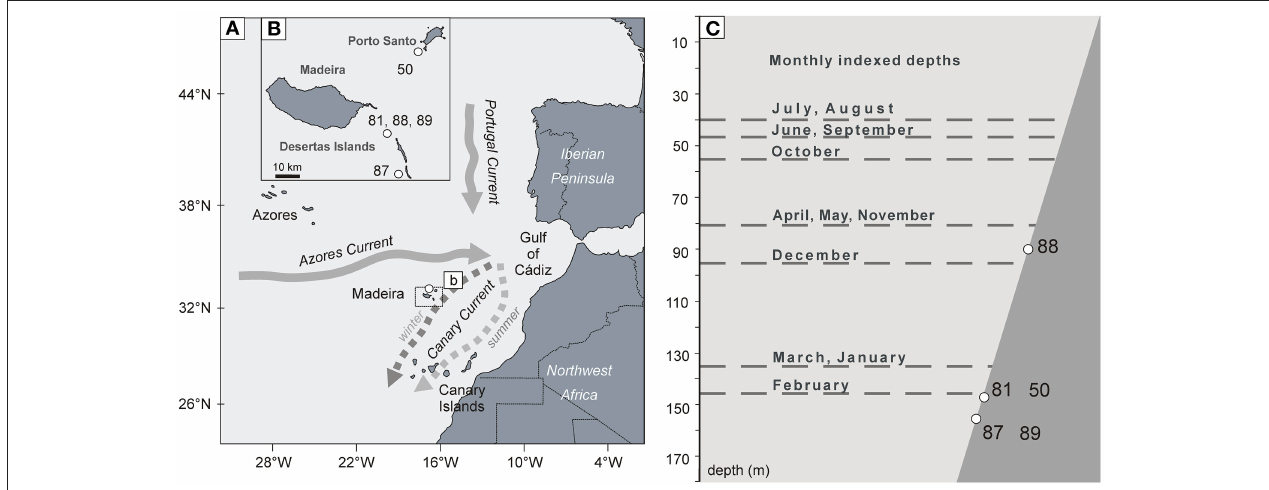
FIGURE 1 | (A) Sketch map of the major ocean currents in the subtropical east Atlantic redrawn from Figure 1 in Mason et al. (2011). (B) The inset sketch map is focused on the Madeira Islands. The numbers indicate the shell collection sites around the islands. (C) Visualization of the relative vertical distribution of the sampling sites compared to the seasonally varying depth of the mixed layer (gray dashed lines); the data were taken from the Subduction Experiment moorings ( Mason et al., 2011